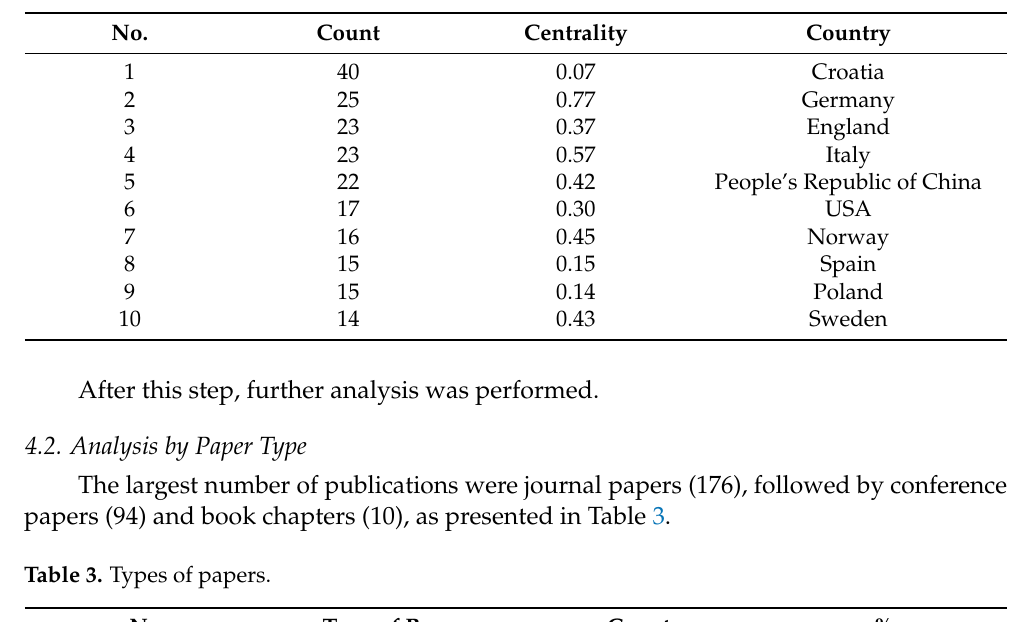
Figure 3. The visualization of the “country cooperation network”.